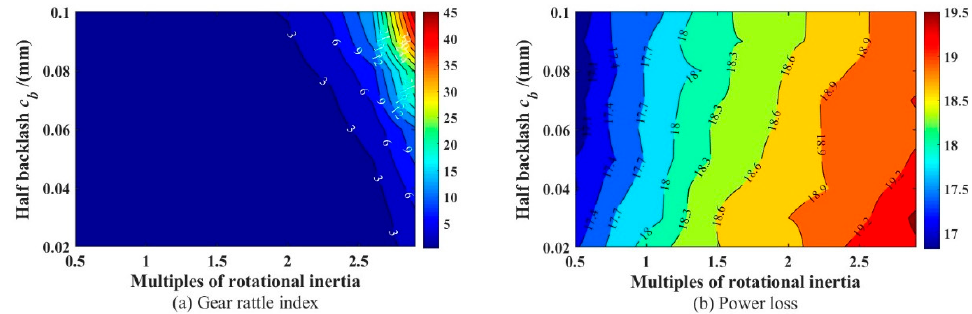
Figure 21. Contour plots of gear rattling index and power loss as a function of moment of inertia and backlash: (a) Gear rattle index; (b) Power loss.